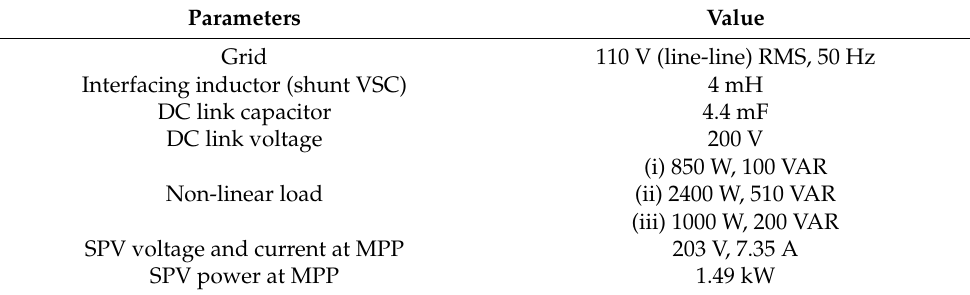
Table 2. Parameters for